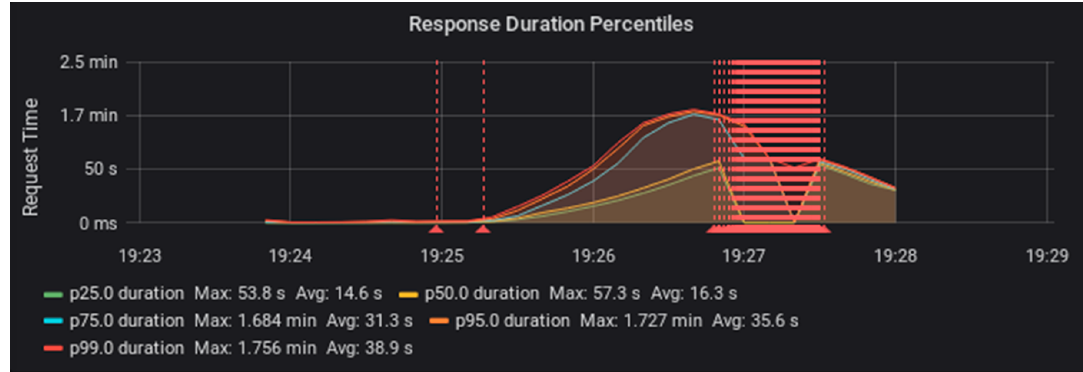
Figure 5. Fedora PostgreSQL system performance degrades at 40 requests per second.